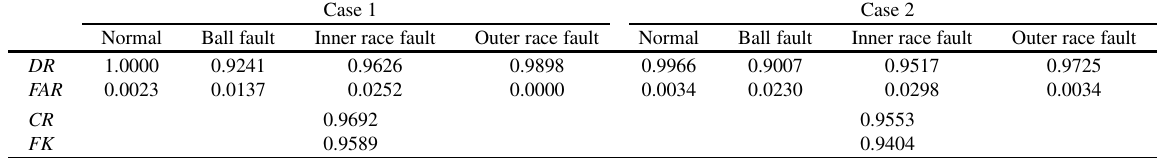
Table 3 Classification results of normal, ball fault, inner race fault and out race